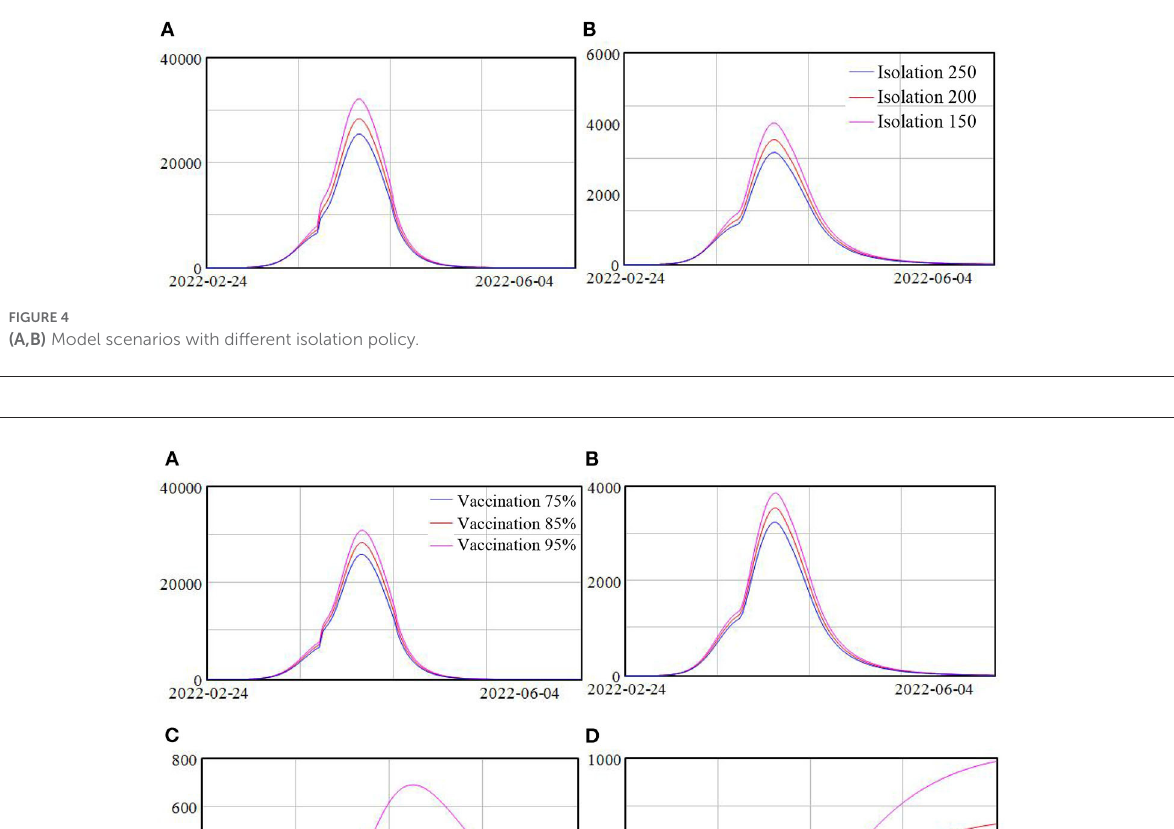
vaccination rate was 95%, representing almost 170%